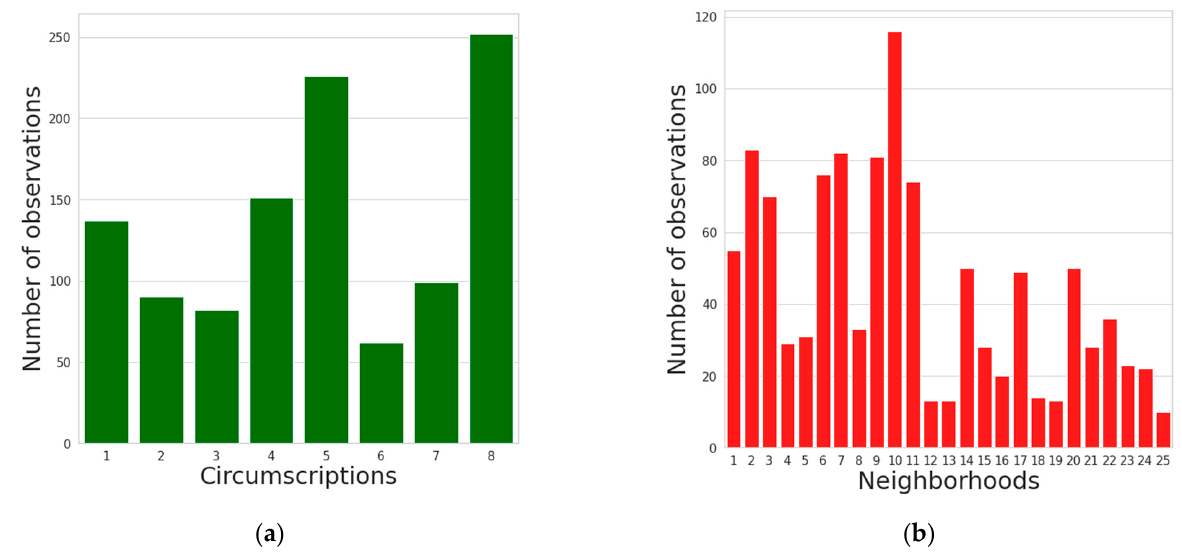
Figure 7. Distributions across ( a ) circumscriptions (left) and ( b ) neighborhoods (right). To analyze the interventions by time, boxplots were used, within the pandas data frame, to relate the divisions to the year group of intervention. These boxplots are given in Figures 8 and 9.